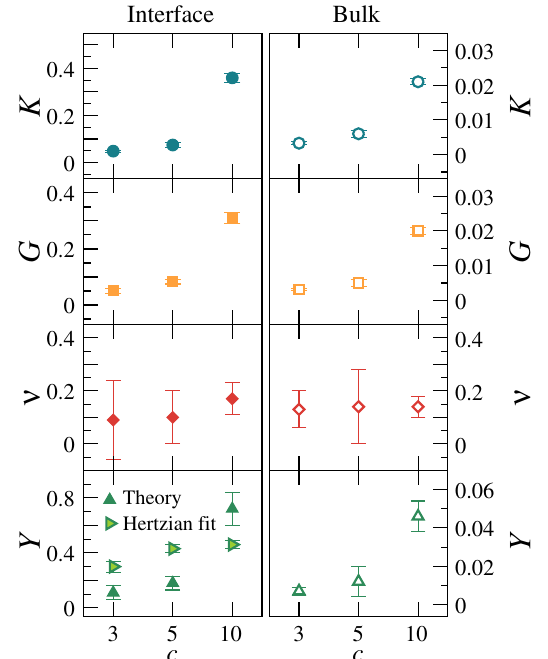
FIG. 3. Elastic moduli at the interface and in the bulk. Bulk modulus K , shear modulus G , Poisson ’ s ratio ν , and Young ’ s modulus Y for the same microgel topology at the interface (full symbols) and in bulk (empty symbols) with explicit solvent as a function of c . In the last row, the theoretical results for Y are also compared to the ones obtained from the effective potential fits with the Hertzian model [Eq. (1)], also reported in Fig. 2(c). K , G , and Y are in units of k B T= σ 3 m to appropriately compare bulk and interface moduli, where the latter moduli are divided by the thickness of the shell at the interface (approximately σ m ); ν is dimensionless. Error bars estimated from the fits of P ð J Þ for K and P ð I Þ for G (see Sec. V) are propagated in the calculation of ν and Y